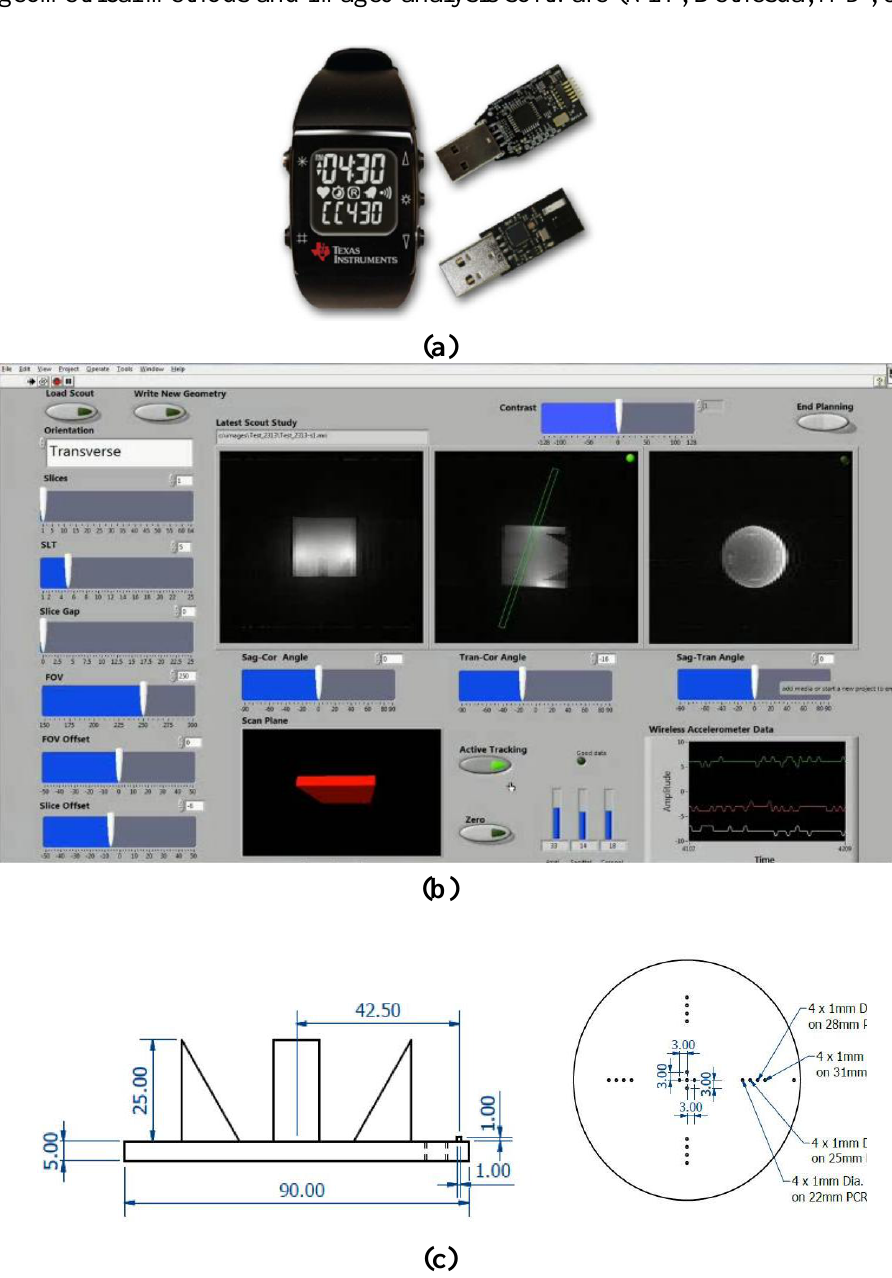
Figure 1. ( a ) The wireless accelerometer (EZ Chronos model 430, Texas Instruments, Austin, Tx, USA) is housed in a sports watch and transmits data from the accelerometer over a 868 MHz radio link to a USB wireless transceiver. Labview software is used to receive the wireless data and interface it to the lesion localization and probe targeting software of specialized interventional MRI systems with a 50 ms update time. ( b ) The customized Labview graphical user interface (GUI). ( c ) The precise geometry of the inserts in the quality assurance (QA) phantom used to assess the angular (±3°) and translational (±1 mm) accuracy of the geometrical planning through the wireless interface. The phantom was 90 mm internal length. Angles and offsets of acquired slices were calculated using the visible spatial features and dimensions of the QA phantom in each planned slice using standard geometrical methods and ImageJ analysis software (NIH, Bethesda, MD,